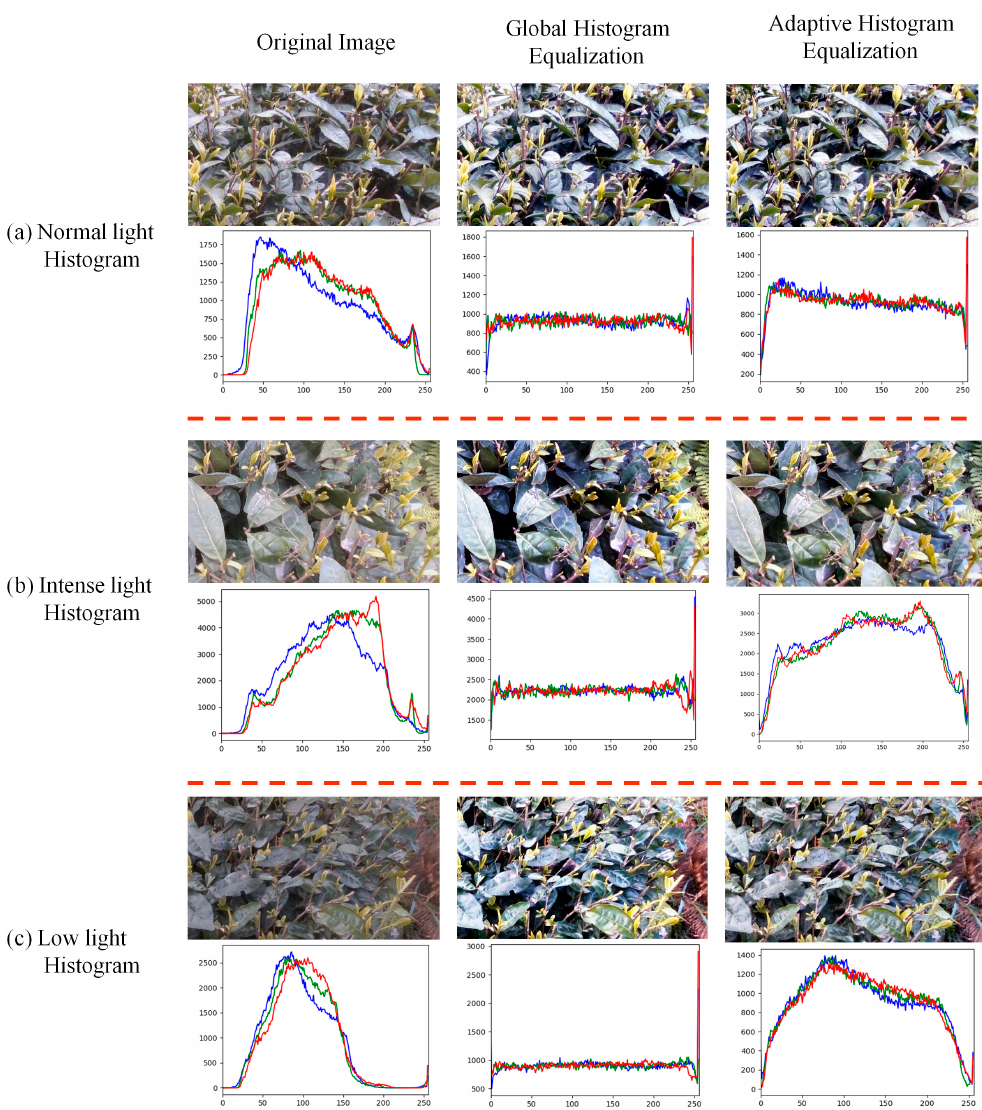
Figure 7. Contrast and histograms of original color and contrast-enhanced images after global and adaptive histogram enhancement under different light conditions: ( a ) normal (9 ‒ 10 a.m.), ( b ) strong (12 ‒ 1 p.m.), and ( c ) low (5 ‒ 6 p.m.). The different colors in the graphs indicate the distribution of the number of pixels in the r, g, b channels.